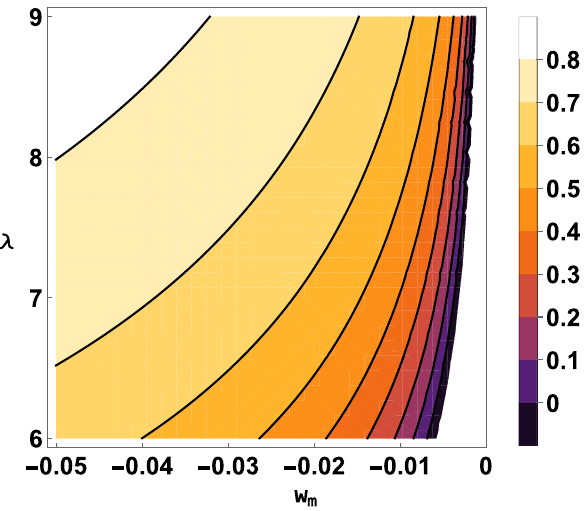
Fig. 2 The figure describes the value of the matter density parameter (cid:12) m as a function of dark matter equation of state parameter the strength of the potential energy, encoded into the value of the λ